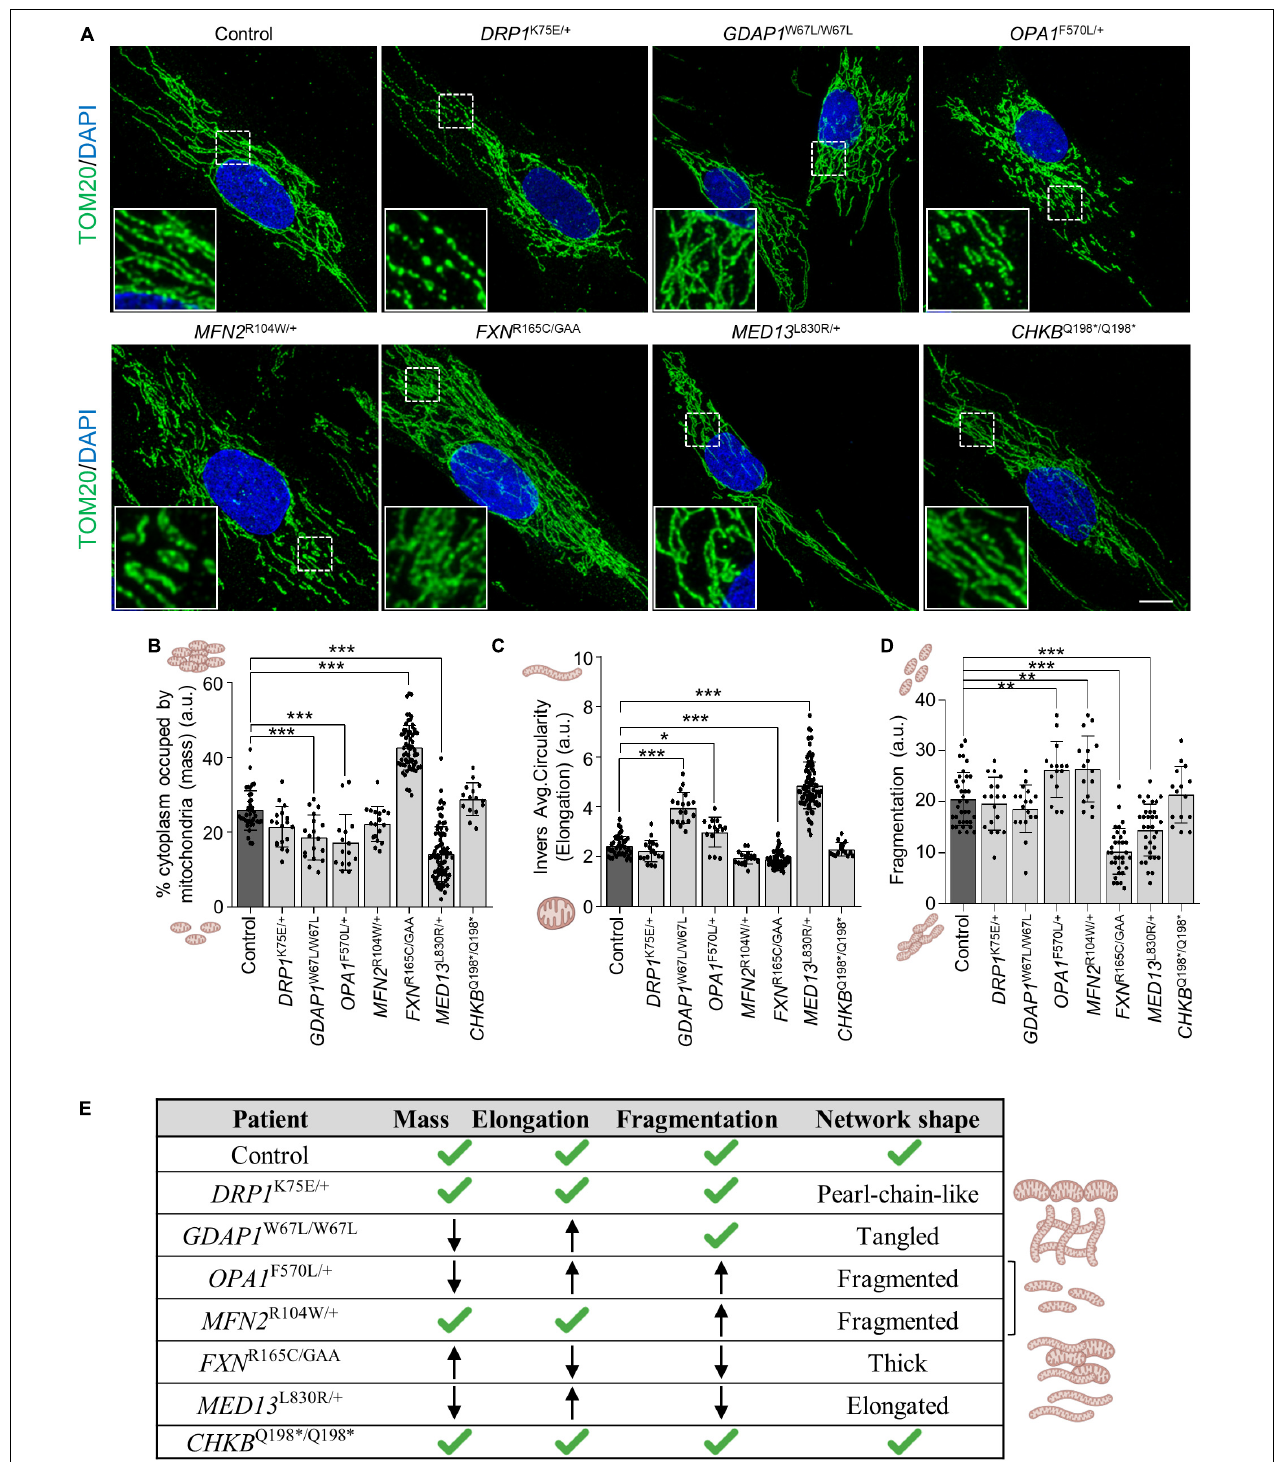
FIGURE 2 | Mitochondrial network shape and quantification of mitochondrial parameters in patients’ fibroblasts. (A) Representative images of TOM20 mitochondrial marker immunofluorescence in control and patients’ fibroblasts. A magnification square is shown. Scale bar: 10 µ m. (B–D) Quantification of mitochondrial mass (percentage of cytoplasm occupied by mitochondria) (B) , mitochondrial elongation (inverse average circularity) (C) , and mitochondrial network fragmentation (D) , in control and patients’ fibroblasts. Data represent mean ± SD and individual values are displayed as dots. One-way ANOVA followed by Dunnett’s multiple comparisons test. Three independent experiments. * P < 0.05, ** P < 0.01, *** P < 0.001. a.u., arbitrary units. (E) Table summarizing network shape and measured mitochondrial parameters.